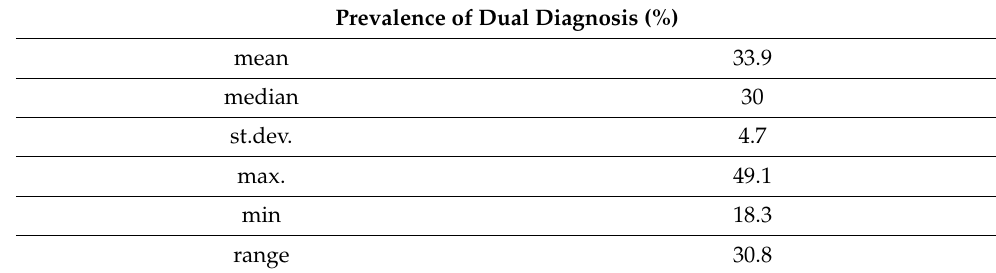
Table 2. Prevalence of dual